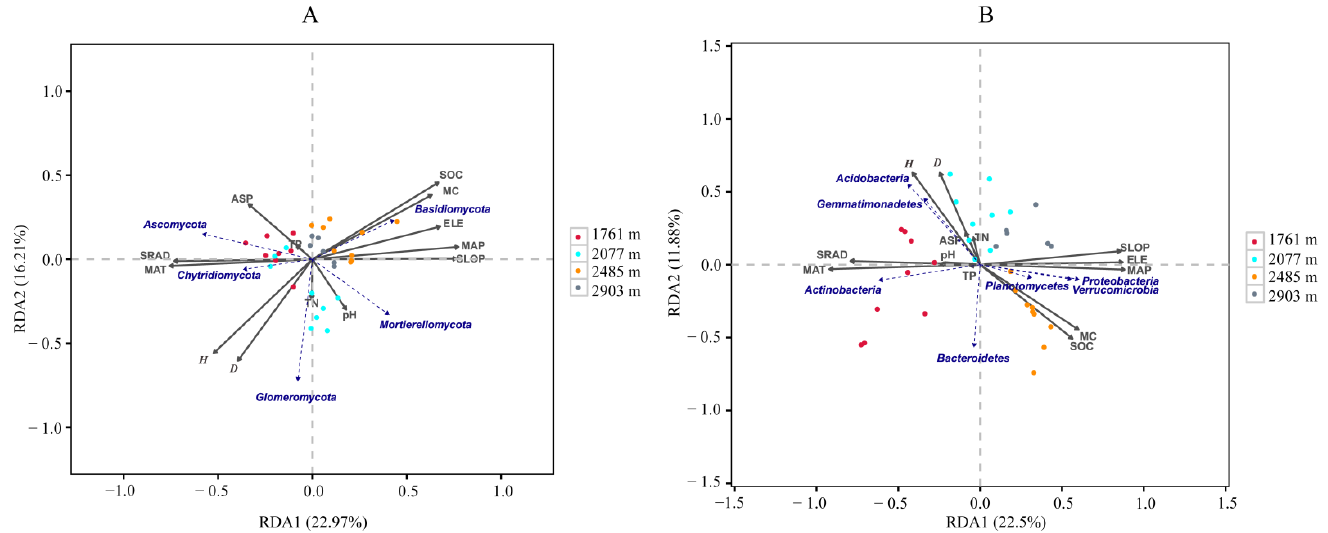
Figure 6. RDA of the soil microbial community at phylum level across the four elevations. The solid close arrows are the environmental factors; the dash close blue arrows represent the dominant phylum of soil fungi ( A ) and bacteria ( B ) that were included in the models. The direction of the arrow indicates a positive or negative correlation between the environmental factors and the ordination axes. The angle of the arrow reflects the strength of correlation between the environmental factors, with small angles indicating strong correlations. MC, soil moisture content; TN, total nitrogen; TP, total phosphorus; SOC, soil organic carbon; ALT, elevation; MAP: average annual precipitation; SRAD, sun radiation; MAT, average annual temperature; ASP, aspect; SLOP, slope; H , Shannon – Wiener diversity; D , Margalef richness.